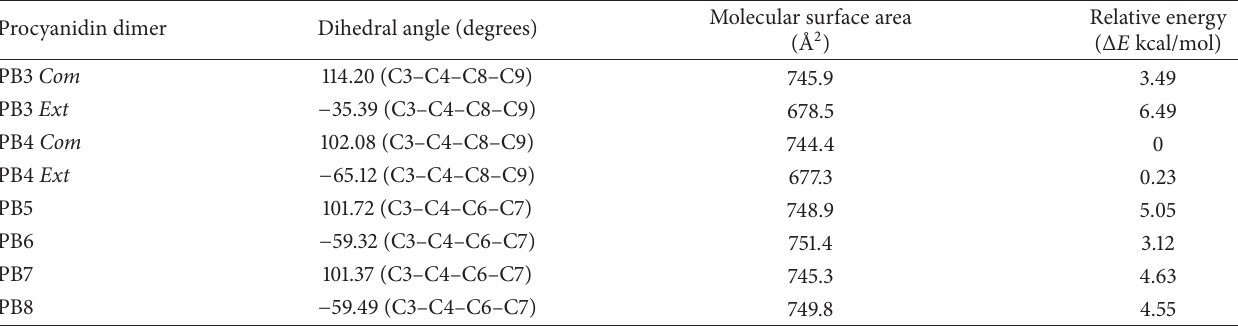
Table 1: Molecular properties and stability ( Δ𝐸 ) of the procyanidin dimers optimized in aqueous medium (SMD model) using the M05- 2X/6- 31 G ∗∗ DFT method.